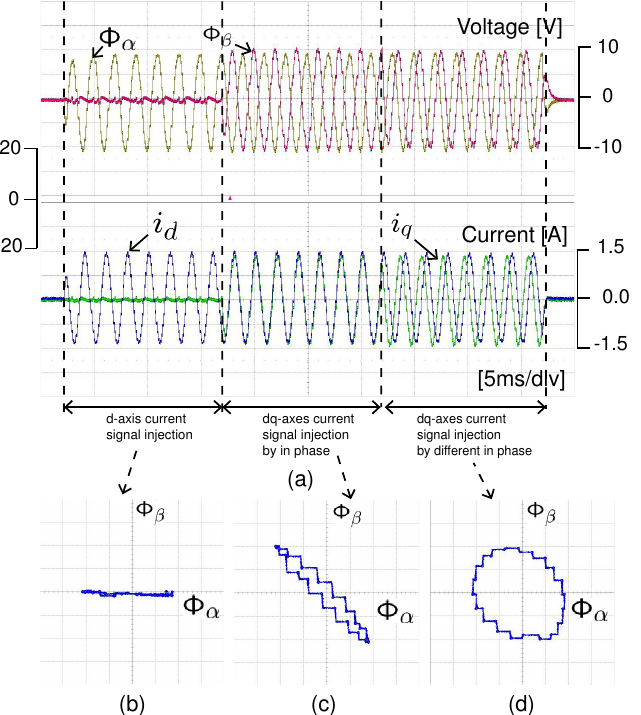
Figure 6. Plots of currents and regression functions: ( a ) currents and ( b – d ) Lissajous contours of Φ α and Φ β